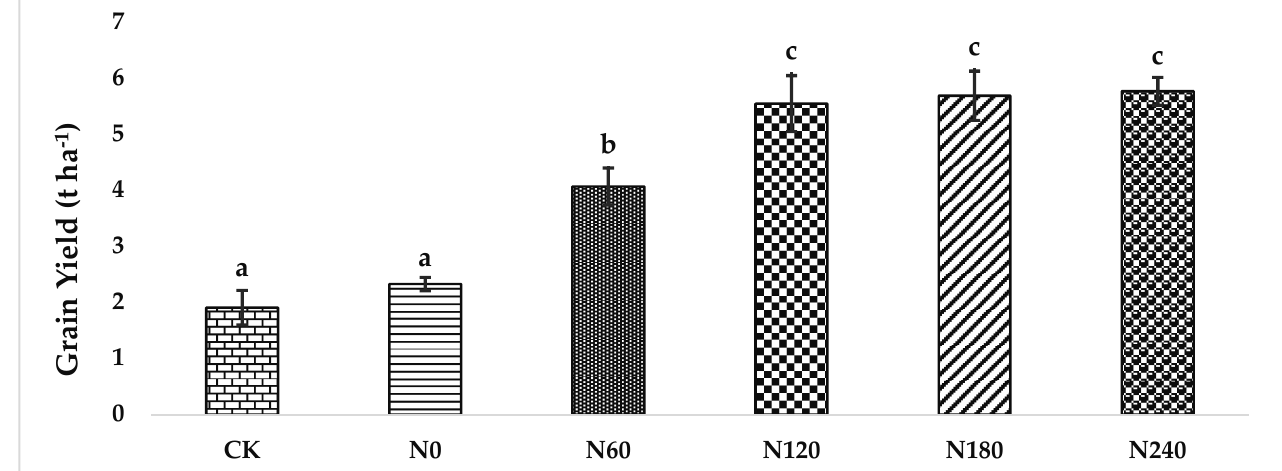
Figure 4. Grain yield produced by different treatments as influenced by Nitrogen doses. CK; control treatment, N0; 0 kg ha − 1 N, N60; 60 kg ha − 1 N, N120; 120 kg ha − 1 N, N180; 180 kg ha − 1 N, N240; 240 kg ha − 1 N, means with similar letters across the treatments denote a non-significant effect ( p ≤